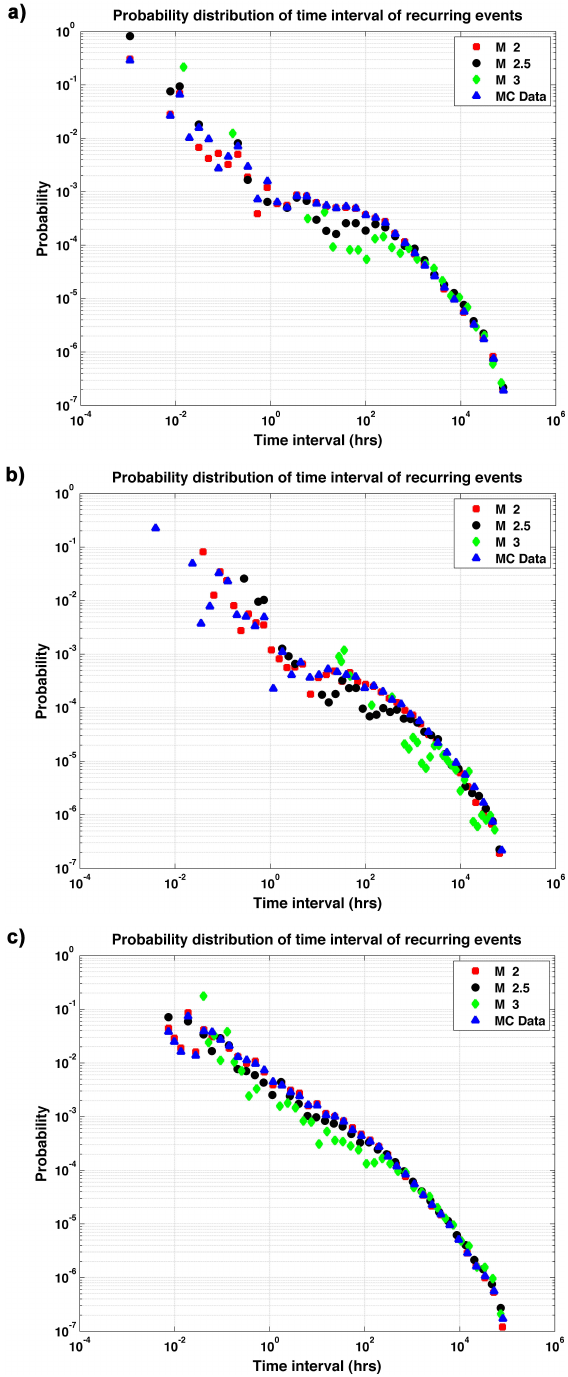
Fig. 8. Distribution of time-intervals between events and their re- currences for different threshold magnitudes. The MC1 results for threshold magnitude m =2 are included for comparison. (a) Re- gion 1; (b) Region 2; (c) Region